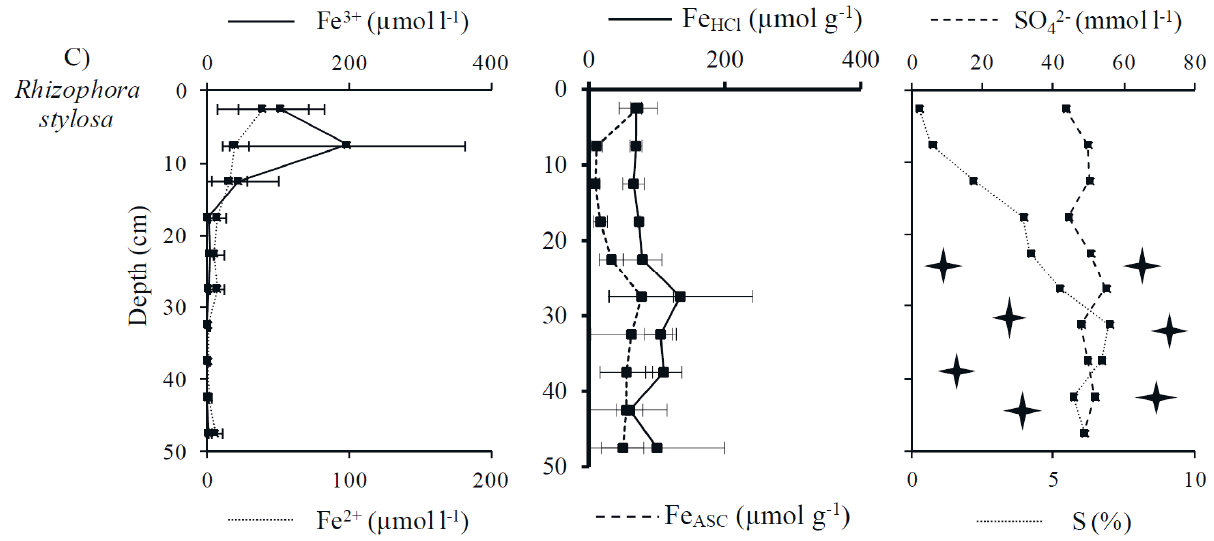
Figure 5. Mean concentrations ( n = 3) and standard deviation of dissolved iron species (Fe 2+ and Fe 3+ ), solid iron phases extracted by ascorbate (Fe ASC ) and by HCl 1N (Fe HCl ). Concentrations ( n = 1) in SO 42 − and total particulate sulfur (S) in sediments of the three vegetation stands. Depth where total dissolved sulfide was detected is indicated by